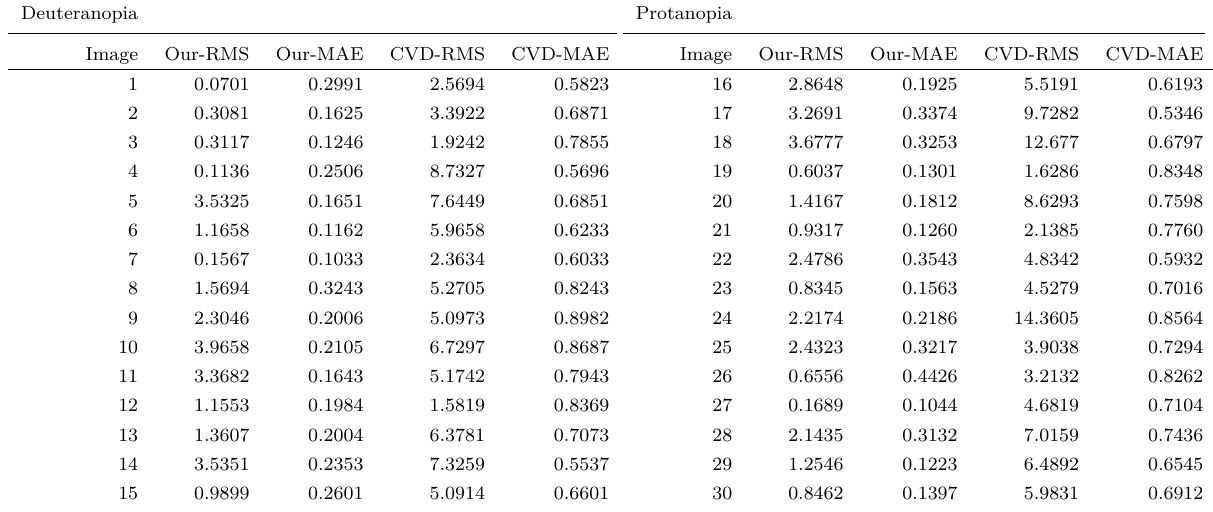
Table 1 Quantitative analysis of saliency detection results for the CVD simulation images and the corrected images